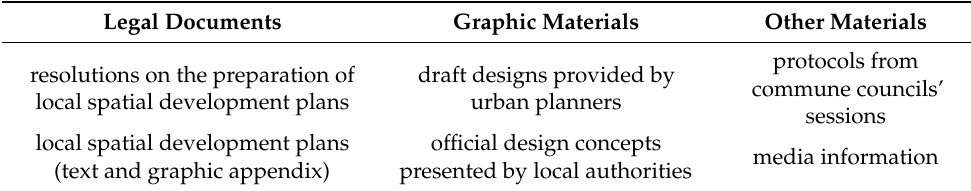
Table 1. Types of materials analyzed in